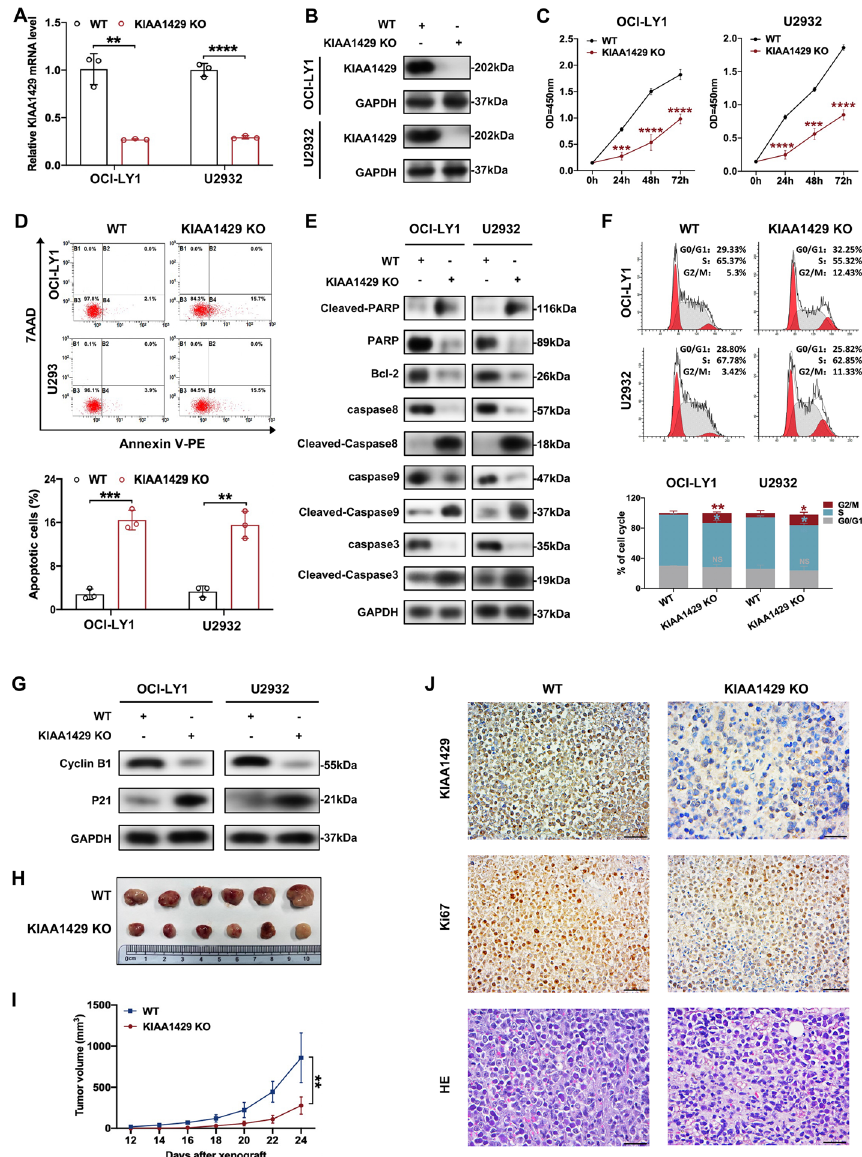
Fig. 3 Deletion of KIAA1429 in DLBCL cells exerted antitumor effects both in vitro and in vivo. A , B Stable knockout of KIAA1429 in DLBCL cells by CRISPR/Cas9 was confirmed by RT-qPCR and western blotting. (WT represents wild-type cells; KIAA1429 KO represents CRISPR/CAS9 knockout cells). Three independent experiments were performed to obtain the data presented as mean SD. ** p < 0.01; **** p < 0.0001. C ± Knockout of KIAA1429 dramatically suppressed the proliferation of DLBCL cells as determined by CCK8 assay. Three independent experiments are presented as mean SD. *** p < 0.001; **** p < 0.0001. D , E KIAA1429 ± deletion facilitated apoptosis and affected the expression of apoptosis-related proteins. Top: representative results; bottom: data from three independent experiments are represented as mean SD. ** p < 0.01; ± *** p < 0.001. F , G The cell cycle was arrested in G2/M phase followed by alterations in cell cycle-associated proteins upon KIAA1429 knockout. Top: representative results; bottom: statistical results from three independent experiments are represented as mean SD. * p < 0.05; ** p < 0.01. H , I SCID beige mice were ± subcutaneously injected with OCI-LY1 cells with or without KIAA1429 deletion ( n 6), and tumor sizes and = volumes were decreased in KIAA1429 knockout cells. ** p < 0.01. J Histological analysis of excised tumors by hematoxylin/eosin (HE) staining and Ki67. Bar, 50